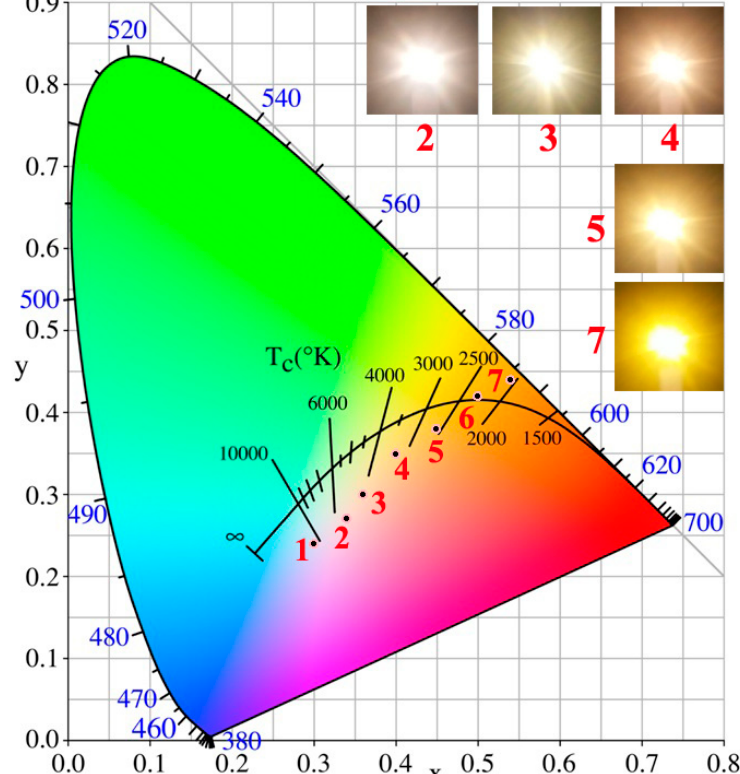
Figure 6. Commission Internationale de L’Eclairage (CIE) chromaticity coordinates of the GaN-based LEDs using the polymer as down-conversion luminescent materials blended in silicone at different concentrations ( x wt %, x = 4.0, 5.0, 5.5, 6.0, 7.0, 8.0, 9.0). Inset: images of the five LEDs, those are, No. 2 (4.0 wt %), No. 3 (5.5 wt %), No. 4 (6.0 wt %), No. 5 (7.0 wt %), and No. 7 (9.0 wt %) in the working state.